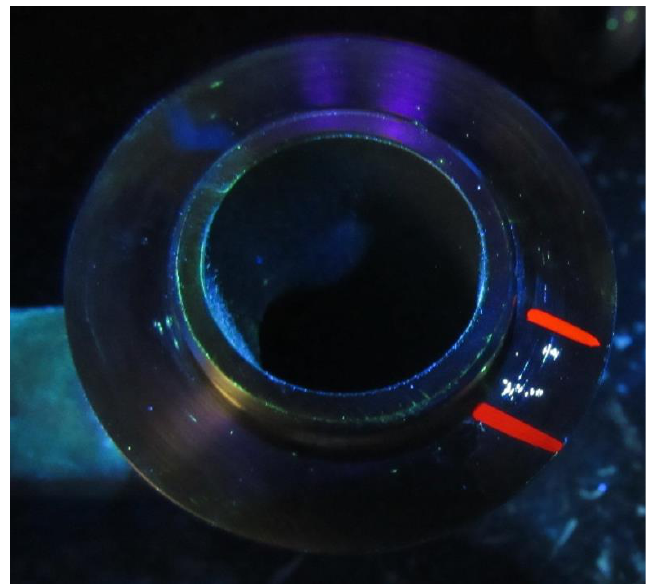
Figure 4. Example of the mechanical seal with porosity cluster.